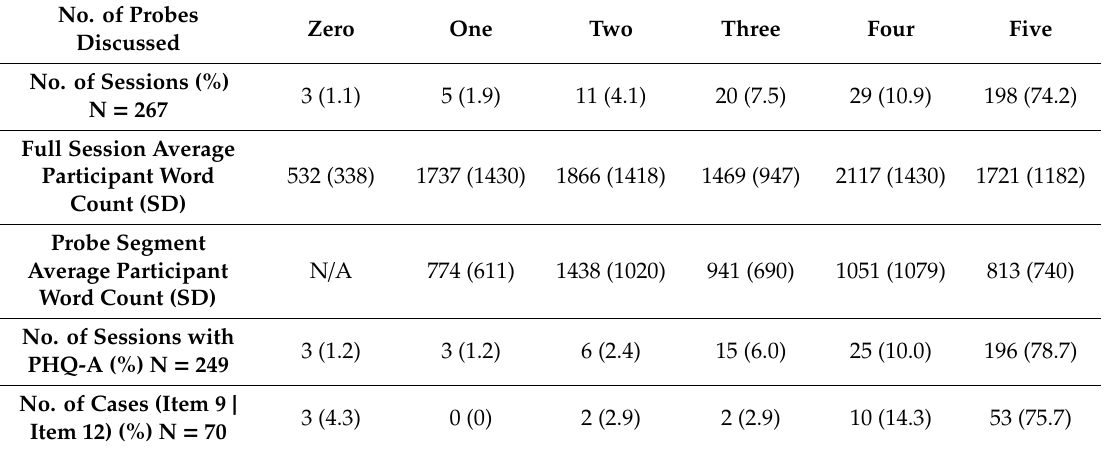
Table 4. Summary of MHSAFE probe usage.